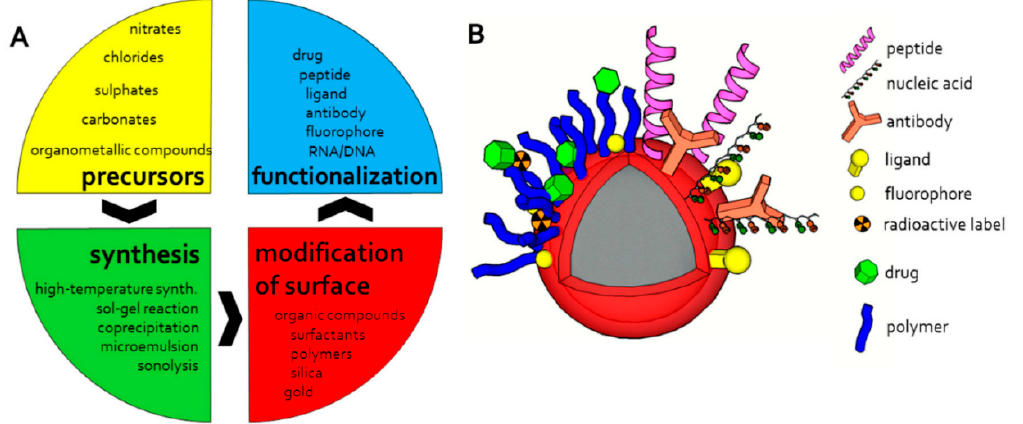
Figure 10. Scheme of magnetic particles design workflow ( A ) and possible modification and functionalization of magnetic particles ( B ). Reprinted from Kudr et al. [89], an open access article